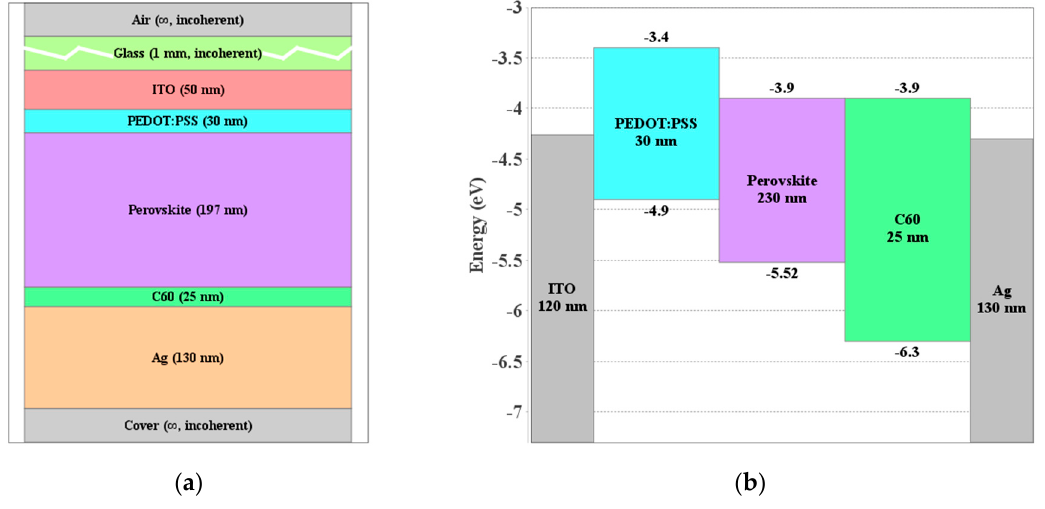
Figure 1. ( a ) Layer stack representing the perovskite cell structure and ( b ) energy band alignment (before contact) of various layers in the PSC.